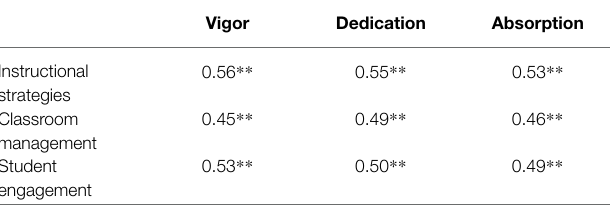
TABLE 7 | Results of Pearson Correlation between all sub-constructs work engagement and all sub-constructs of TSE.